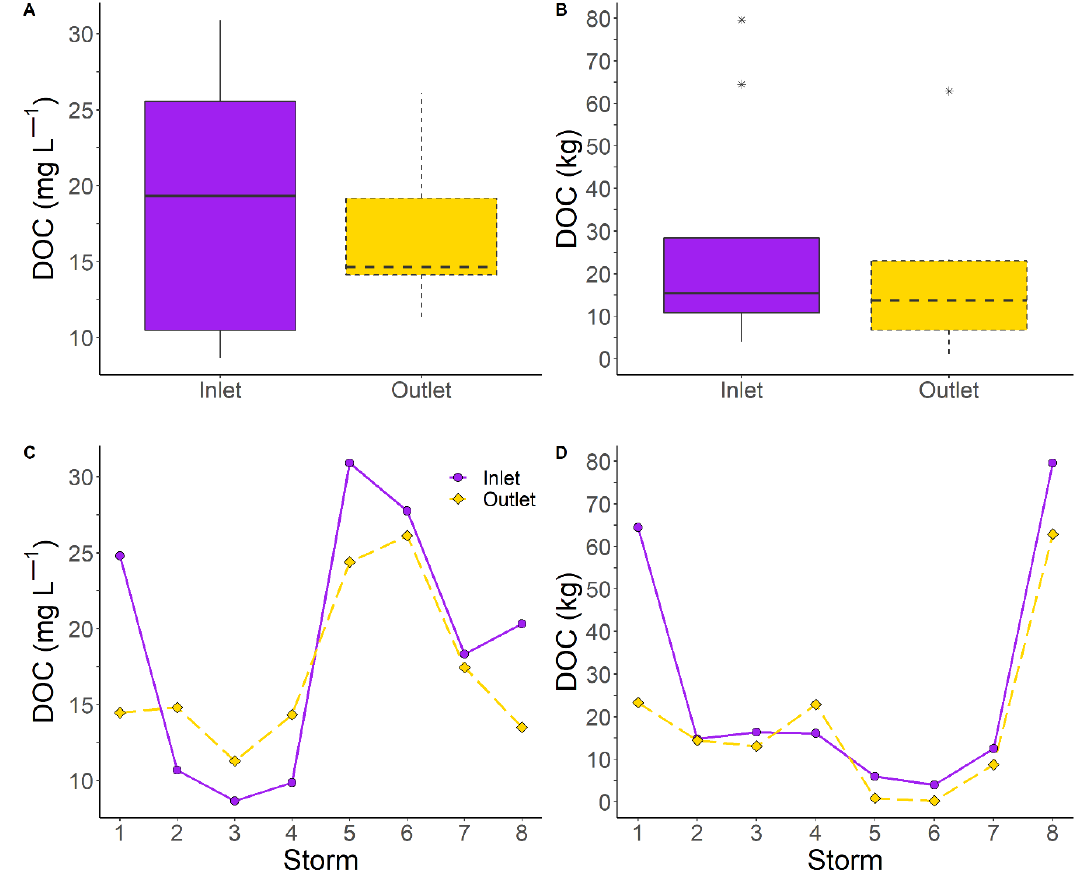
Figure 9. Event mean concentrations ( A , C ) and masses ( B , D ) of dissolved organic carbon (DOC) at the inlet and outlet of the dry detention basin. Statistical outliers are shown as (*).